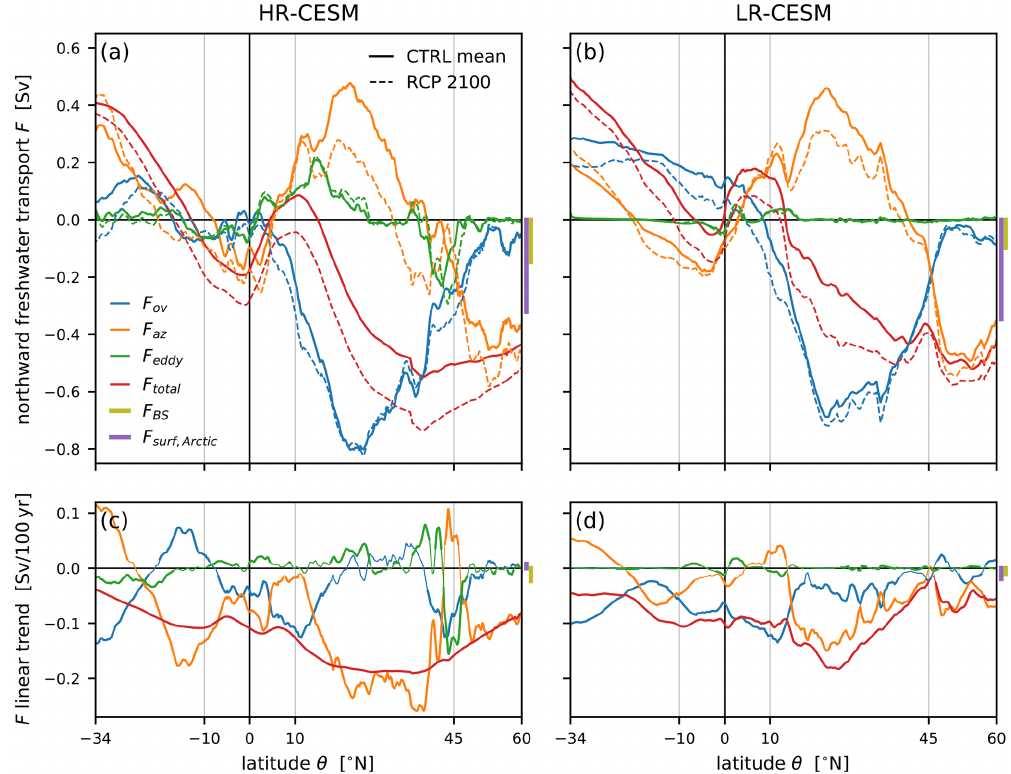
Figure 7. The meridional freshwater transport as a function of latitude θ for the HR-CESM (a, c) and LR-CESM (b, d) simulations. In panels (a) and (b) , solid lines are the means of the 30 CTRL years following the branch-off point and dashed lines are the year-2100 values of the linear RCP fit. The total transport terms (red) are decomposed into an overturning (blue), an azonal gyre (orange), and an eddy contribution (green). Panels (c) and (d) show the linear trends separately. Significant trends (at the 5% level) are thick, while insignificant trends are only thin. Vertical bars to the right of the panels illustrate the Arctic surface flux in the Arctic (purple) and the Bering Strait inflow (olive) of